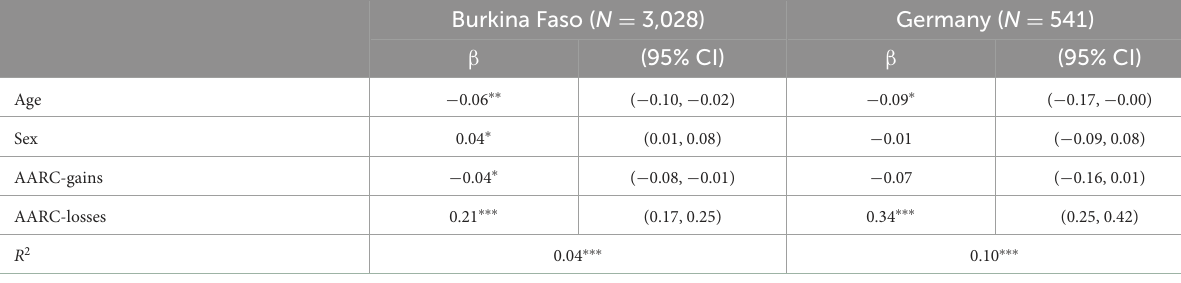
TABLE 1 Linear regression for the relationship between subjective age (outcome) and AARC-gains as well as AARC-losses controlled for age and sex in the samples from Burkina Faso and Germany.